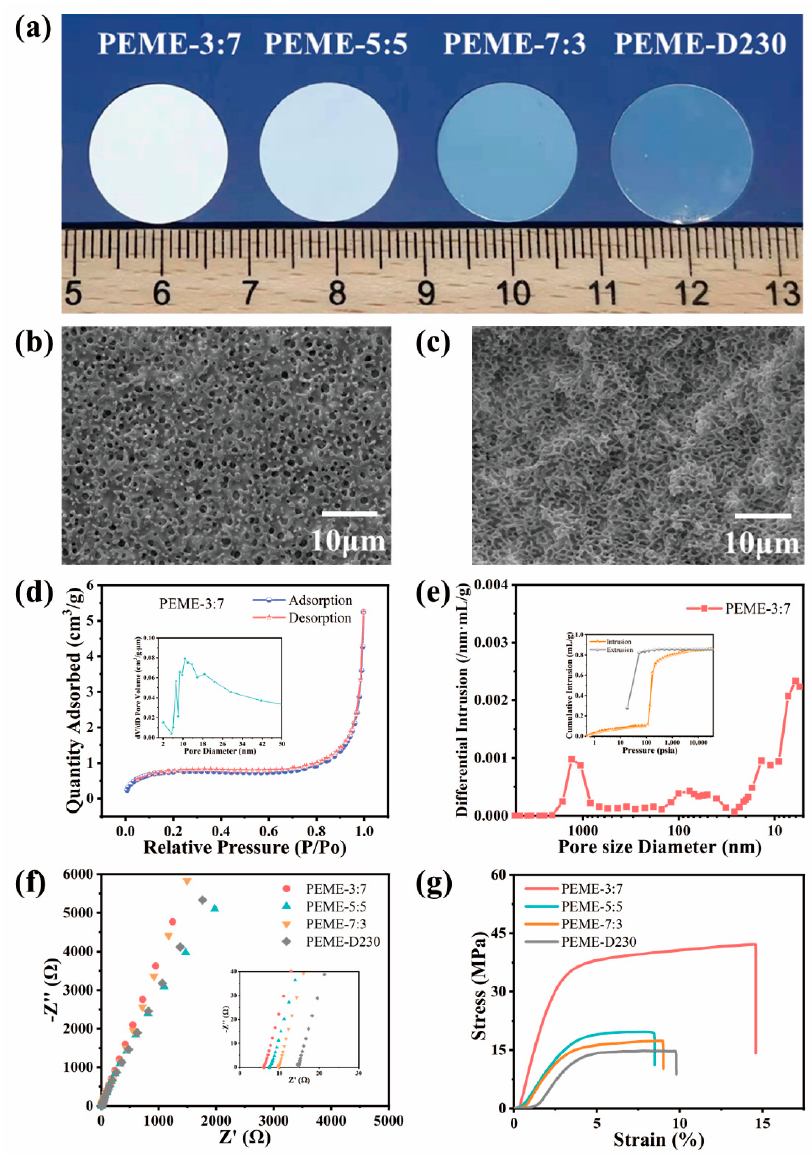
Figure 2. ( a ) Digital photos of PEME-x membranes. The ( b ) surface and ( c ) cross-section SEM